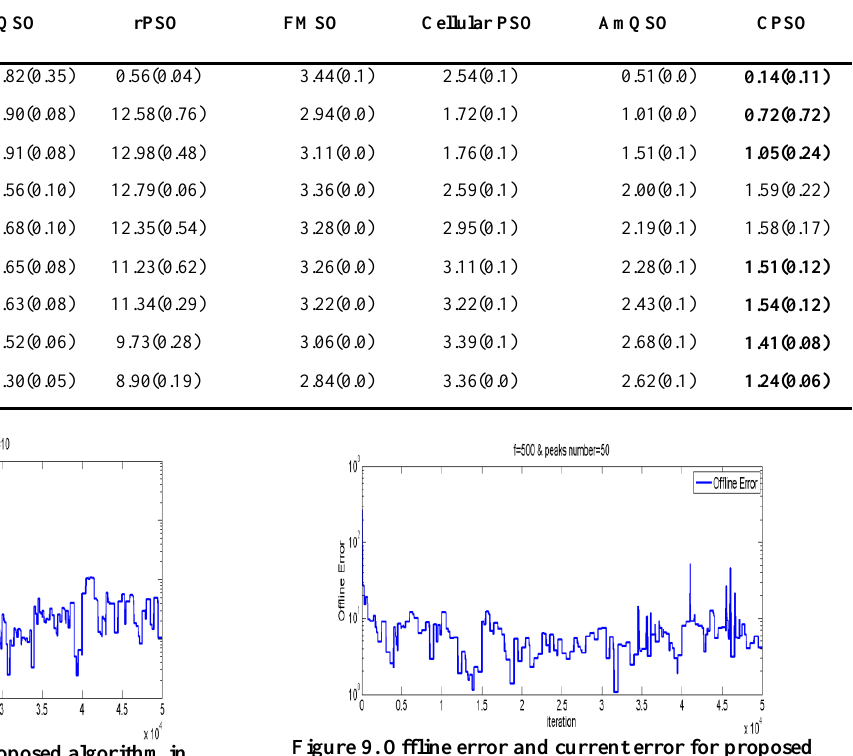
Figure 8. Offline error for proposed algorithm in frequency = 500 and peaks number = 10.